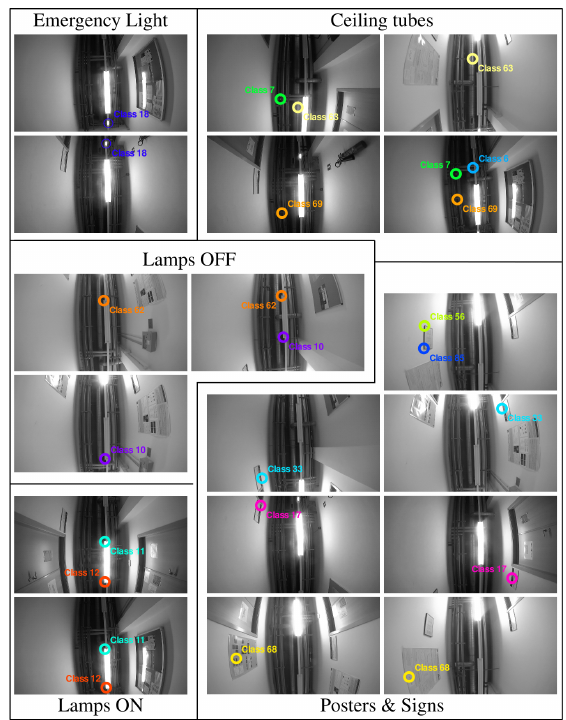
Figure 10. Examples of classes created by our method that correspond to real scene elements. Most of the classes are detected on various frames, and on different sides of the images. (Best seen in